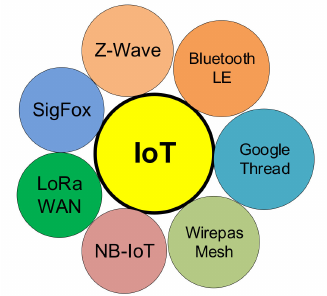
Figure 1. IoT communication protocols. Viable communication protocols that can be integrated into